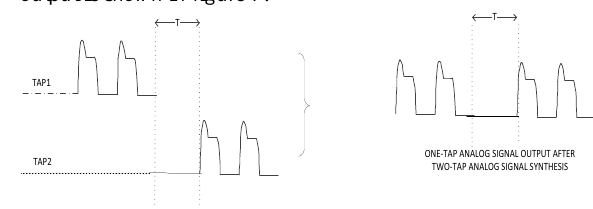
Figure 7. Result picture after analog